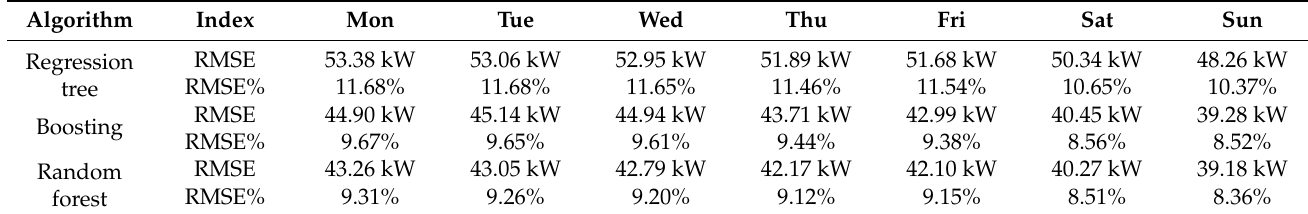
Table 3. Error comparison among weekdays.